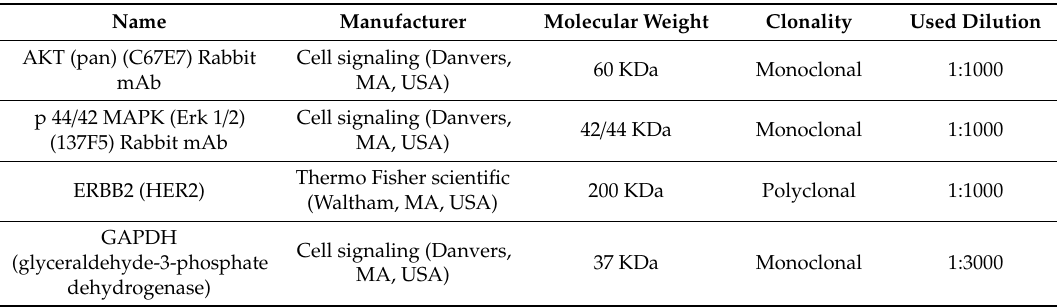
Table 2. Information for the primary antibodies used for western blot in this